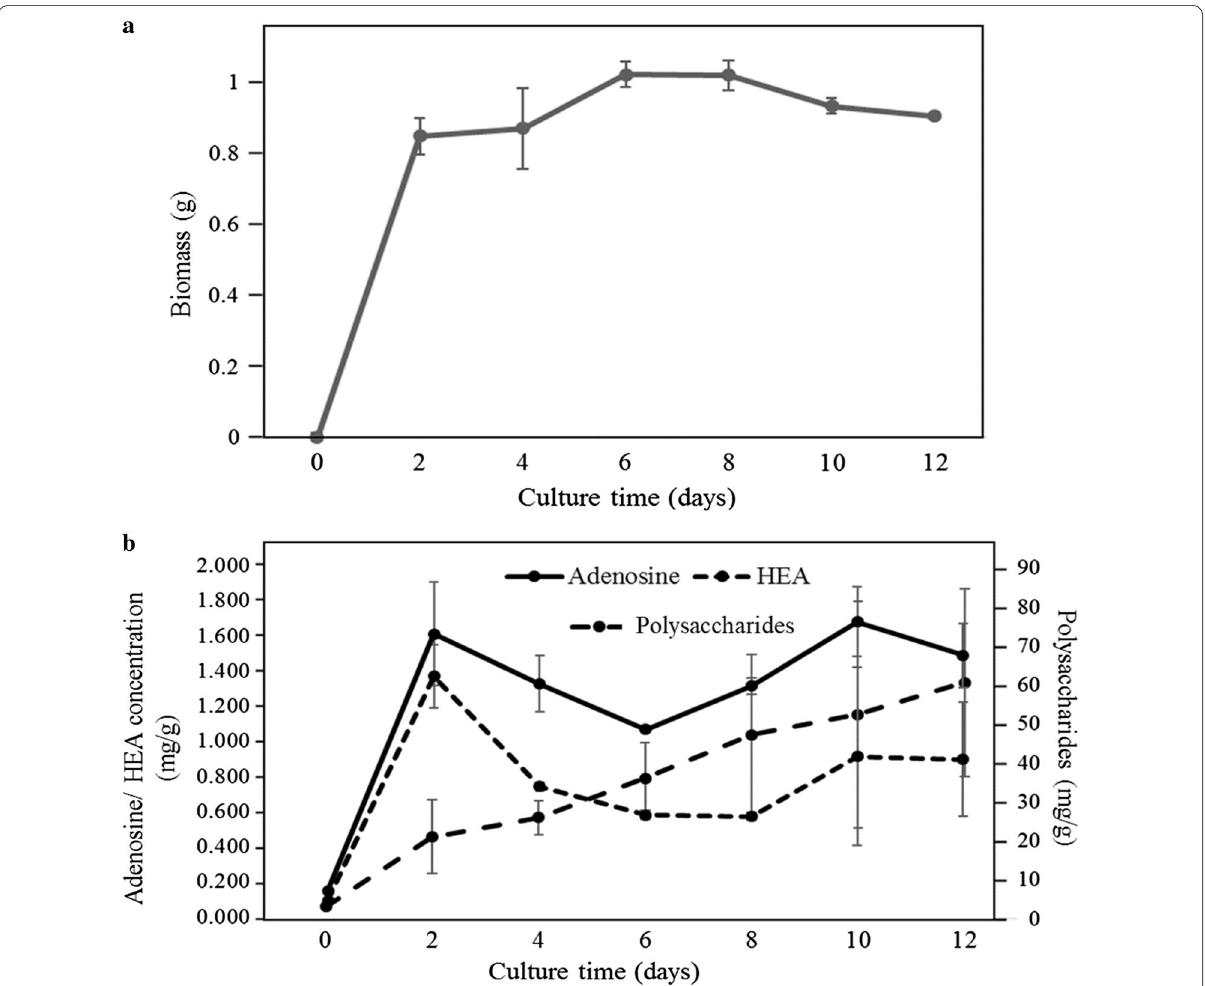
Fig. 2 Growth curve of submerged‑fermented C. cicadae NTTU 868 mycelium and the change of adenosine and HEA concentration: a dry mycelium biomass; b adenosine, HEA and polysaccharide concentration by using HPLC analysis. The data is presented as the mean